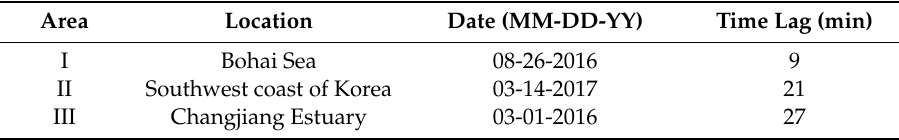
Figure 1. ( a ) Bathymetry for the Bohai Sea, Yellow Sea, and East China Sea. Three highly turbid water areas are outlined in three boxes (I, II, and III). Panels ( b – d ) are the composed RGB pictures of the three examples used for comparison (B: 490 nm, G: 555 nm, and R: 680 nm). Table 1. Detail information on the processed images.